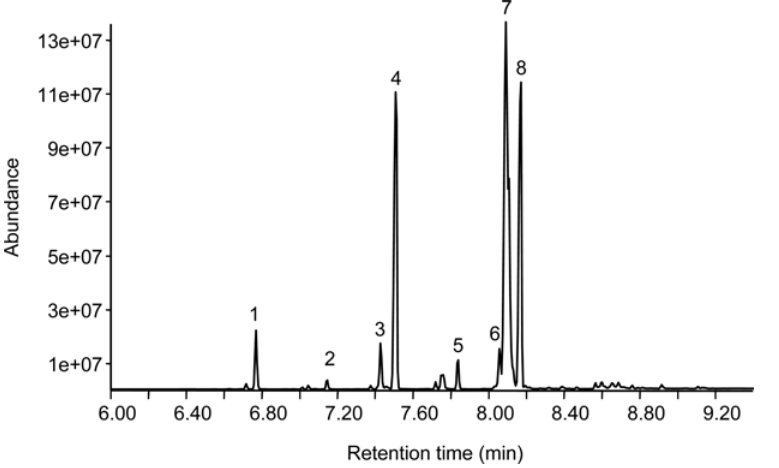
Figure 1. Low temperature alkaline methanolysis leads to efficient biodiesel production from MBM spiked with 5% hamster brain. After alkaline methanolysis of MBM the upper biodiesel phase was separated and analyzed by GC-MS. GC-MS results show the alkaline methanolysis reaction produced various fatty acid methyl esters (FAME) which are typical components of biodiesel (see Table 1 for FAME composition). The two most abundant fatty acid methyl esters were analyzed quantitatively by using internal deuterated standards and calibration curve (Table 2).